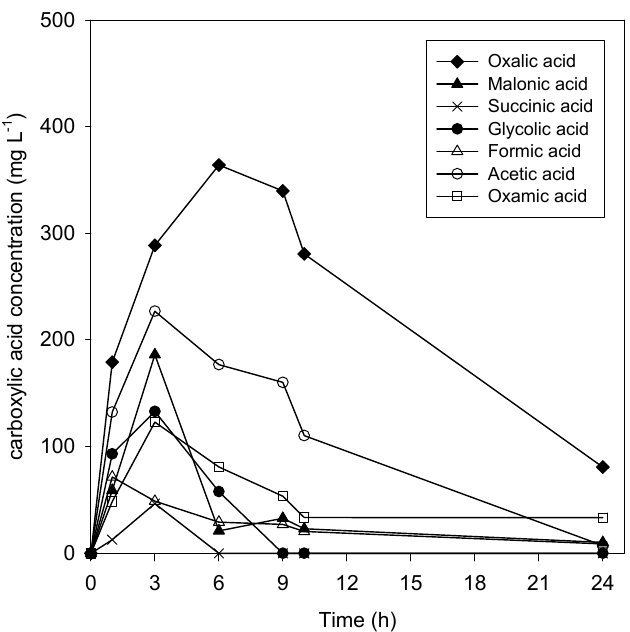
Figure 4. Concentration–time profile of carboxylic acids formed during the EF regeneration process.